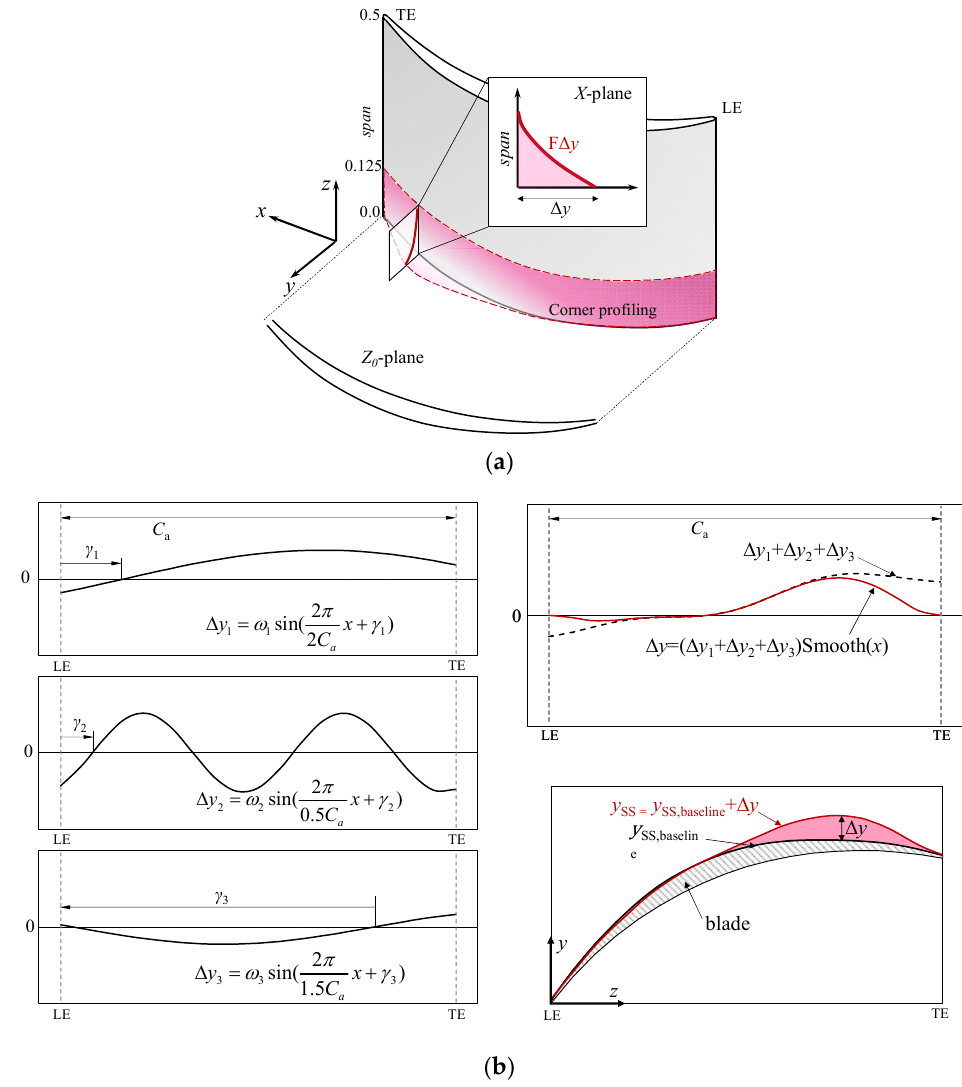
Figure 1. Parameterization of the SS corner profiling. ( a ) Three-dimensional sketch of the SS corner profiling; ( b ) definition of the